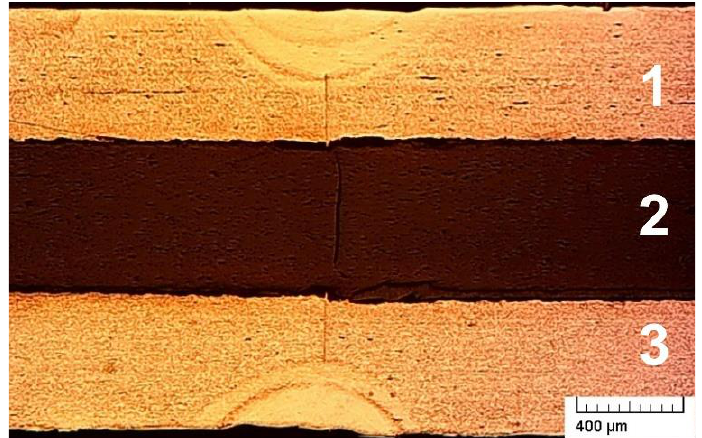
Figure 3. Cross-section of the joint area: 1, 3 — dual-phase steel sheets with a thickness of 0.48 mm; 2 — the core material with a thickness of 0.6 mm.